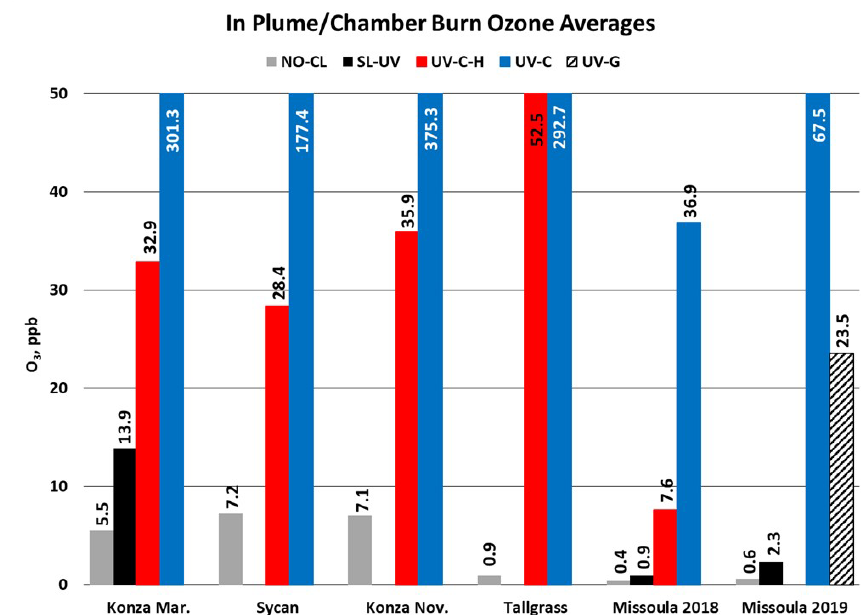
Figure 2. In-plume O 3 concentration averages from the 2017 prescribed grassland burns and the 2018 and 2019 Missoula chamber burns. For the 2017 grassland burning periods, CO concentration results ( ≥ 1ppm) were used as an indicator of when in-smoke sampling was